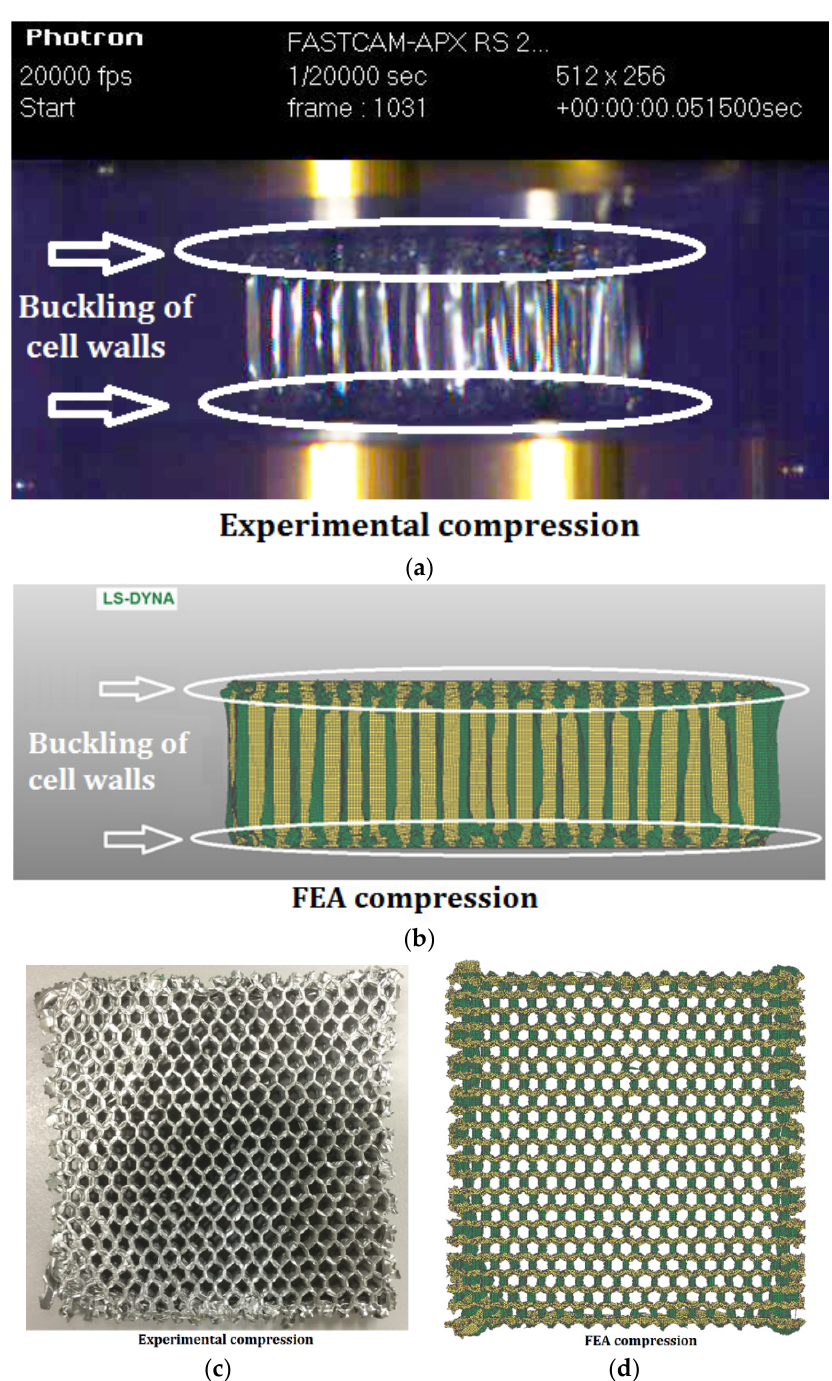
Figure 2. Comparison between experimental and simulated deformation mode of honeycomb H31 under compression: ( a ) experimental result; ( b ) FEA result; ( c ) experimental post ‐ test specimen; ( d ) FEA post ‐ test specimen.